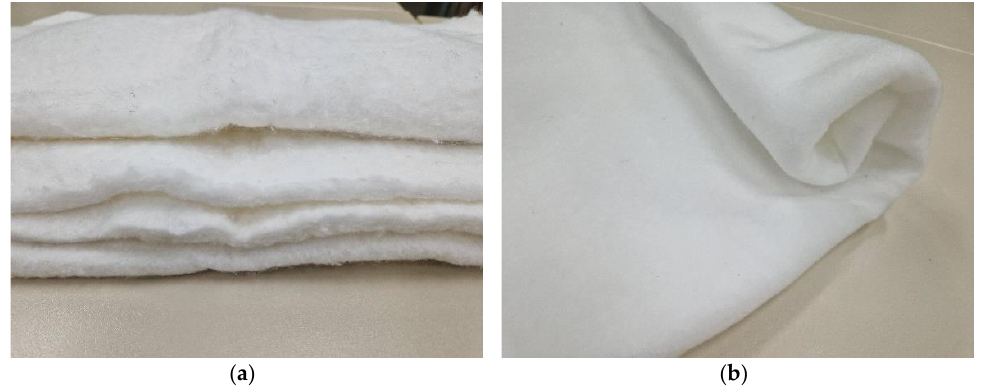
Figure 4. The nonwoven mulches produced by ( a ) viscose and ( b ) PLA nonwoven mulches.